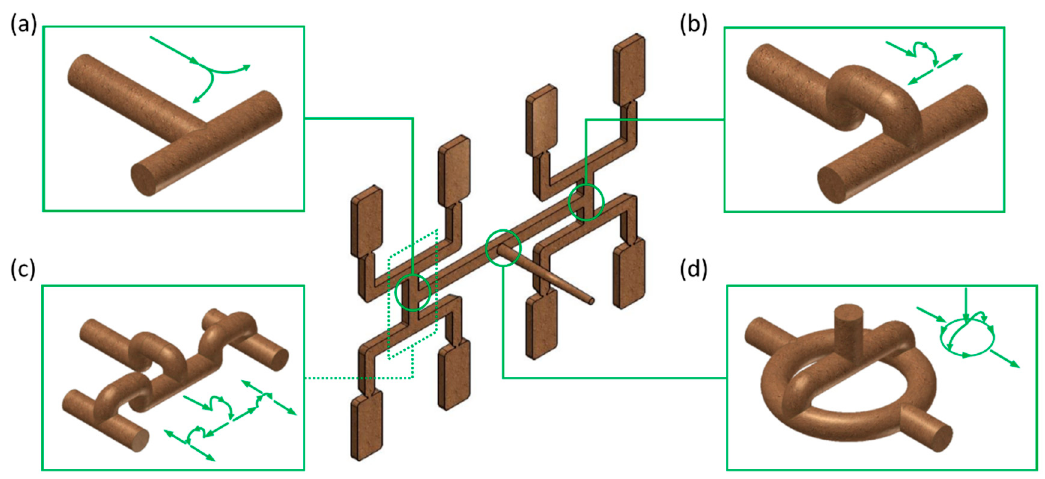
Figure 2. Geometry of runner layouts: ( a ) standard GS , ( b ) one correction element G 1, ( c ) two correction elements G 2, and ( d ) circled element G 3 [2].